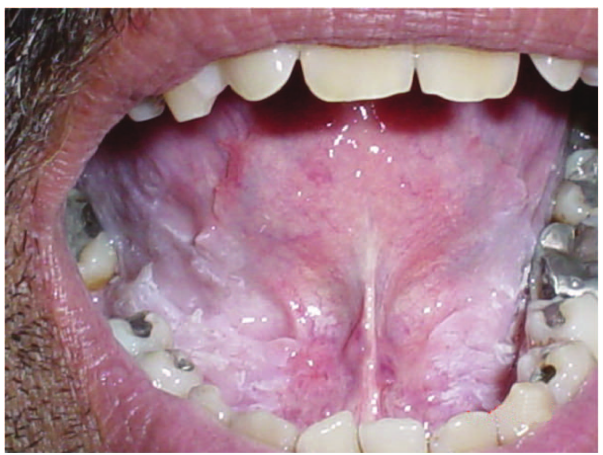
Figure 5 - Ventral surface of tongue and floor of the mouth after 2 weeks of peroxide